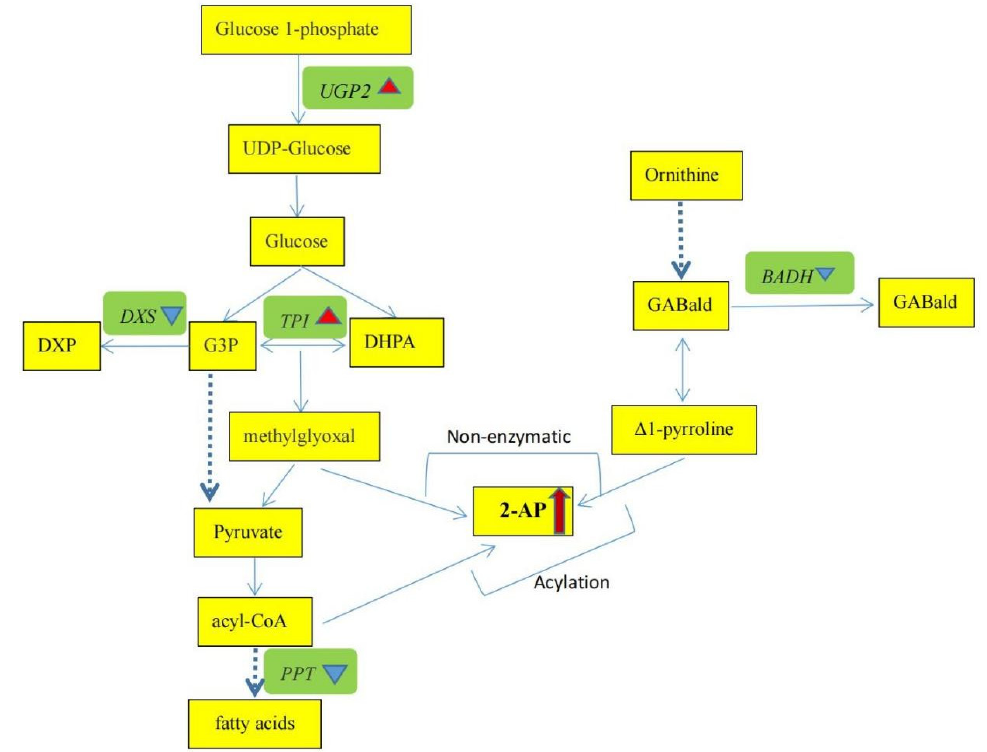
Figure 3. Expression patterns of the 2-acetyl-1-pyrroline-related genes. The green boxes represent genes and the yellow boxes represent metabolites. The red triangle represents the higher level in No. 312, the blue triangle represents the lower level in No. 312, and red arrow represents the higher content of 2-acetyl-1-pyrroline in No. 312.